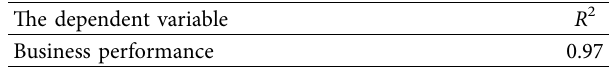
Table 8: The variance described for the dependent variables.